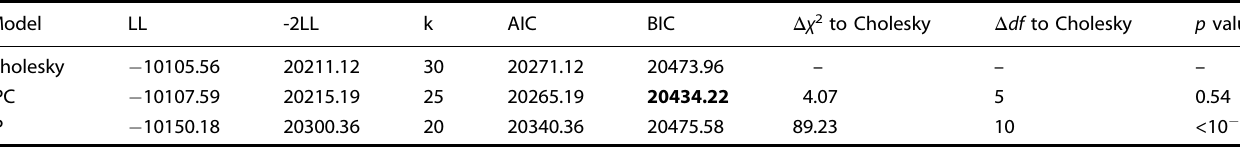
Table 4. Multi-domain GSEM model fi t comparisons of word reading subset.